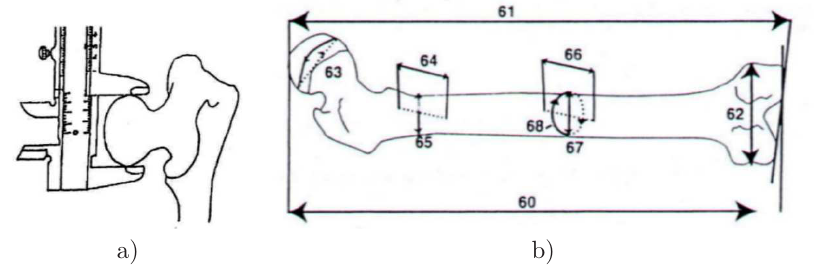
Figure 1. The example of measurement process and view on a few characteristic points for femur bone.